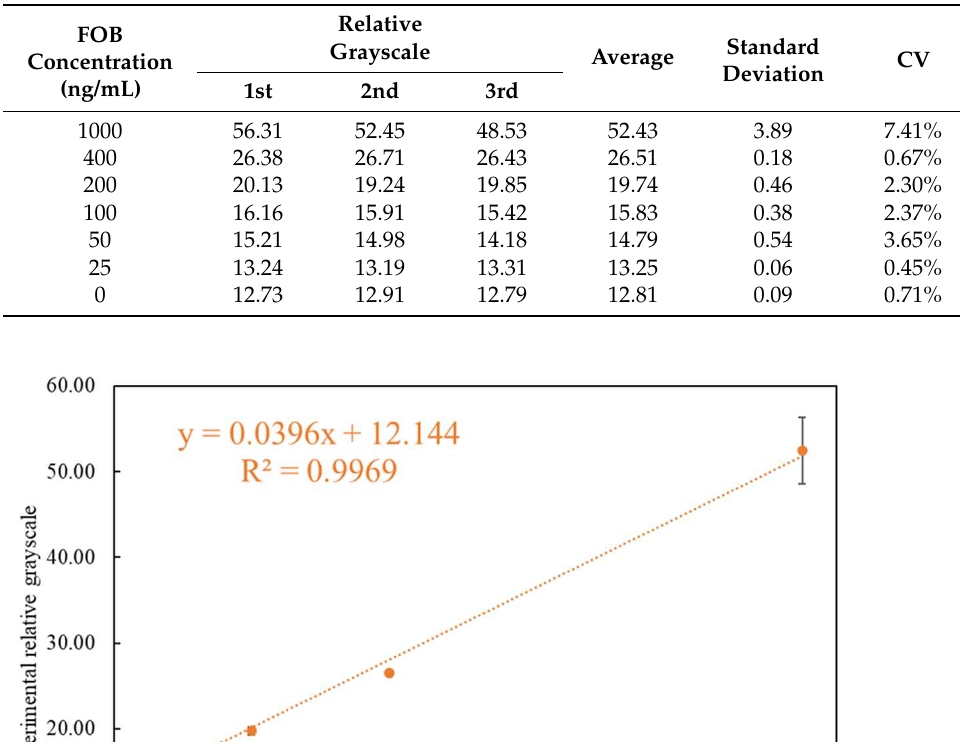
Table 1. Relationship between the detected relative experimental grayscale and FOB concentrations.